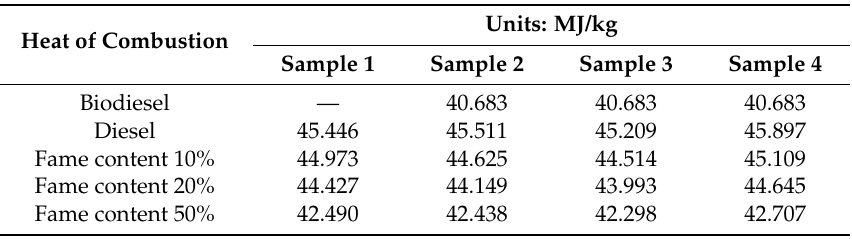
Table 6. Heat of combustion of oil samples.